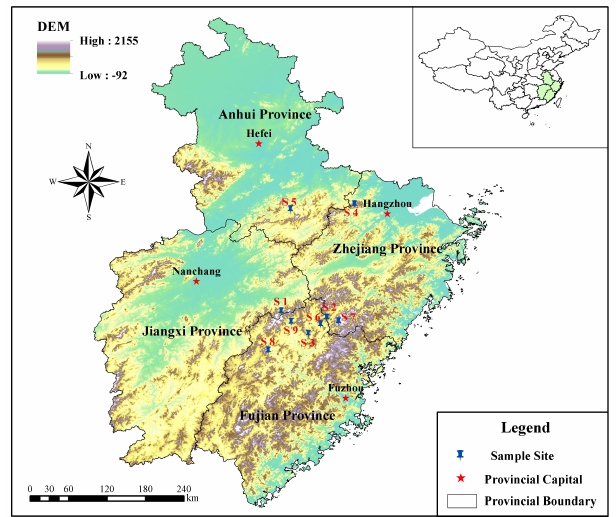
Figure 12. The distribution of nine main producing areas of W. japonica.